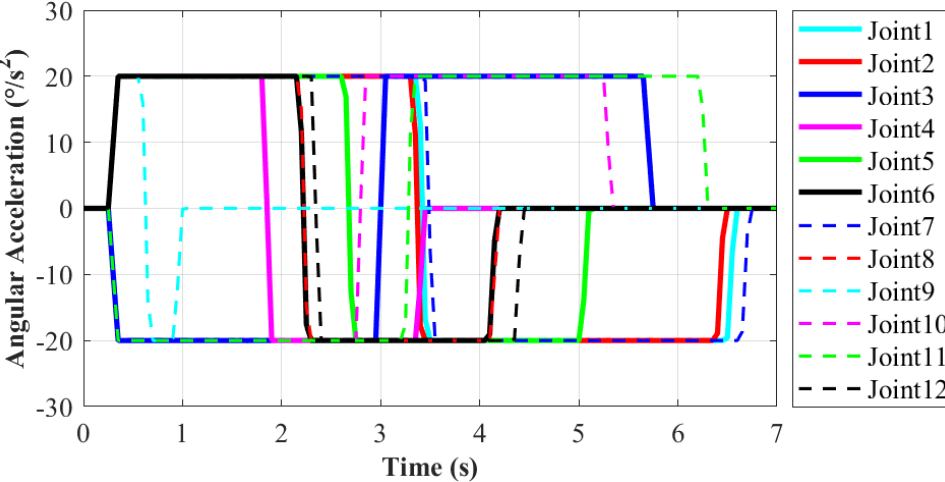
Figure 12. The angular acceleration variation of each joint. (Action 9 according to Table 1). According to the motion planning, in order to make the motion relatively stable, the maximum angular velocity and acceleration of each joint are limited. The